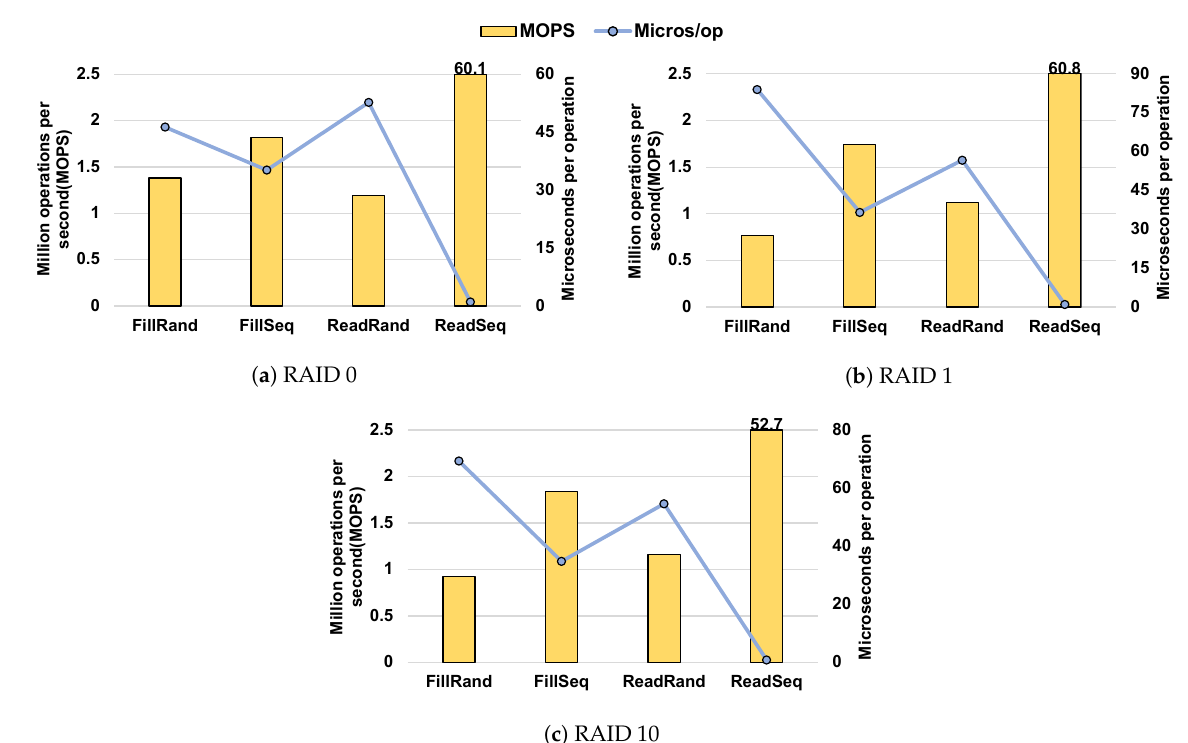
Figure 6. Experimental results under different RAID schemes (RAID 0, 1, and 10) via DBbench.